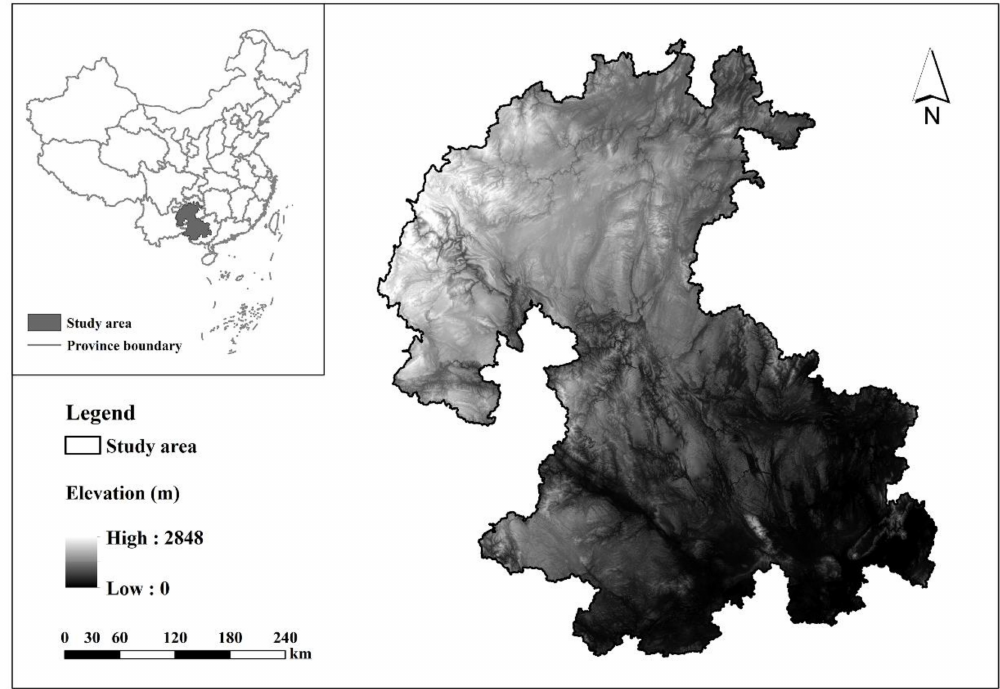
Figure 1. Location and terrain of the Guizhou and Guangxi karst mountains